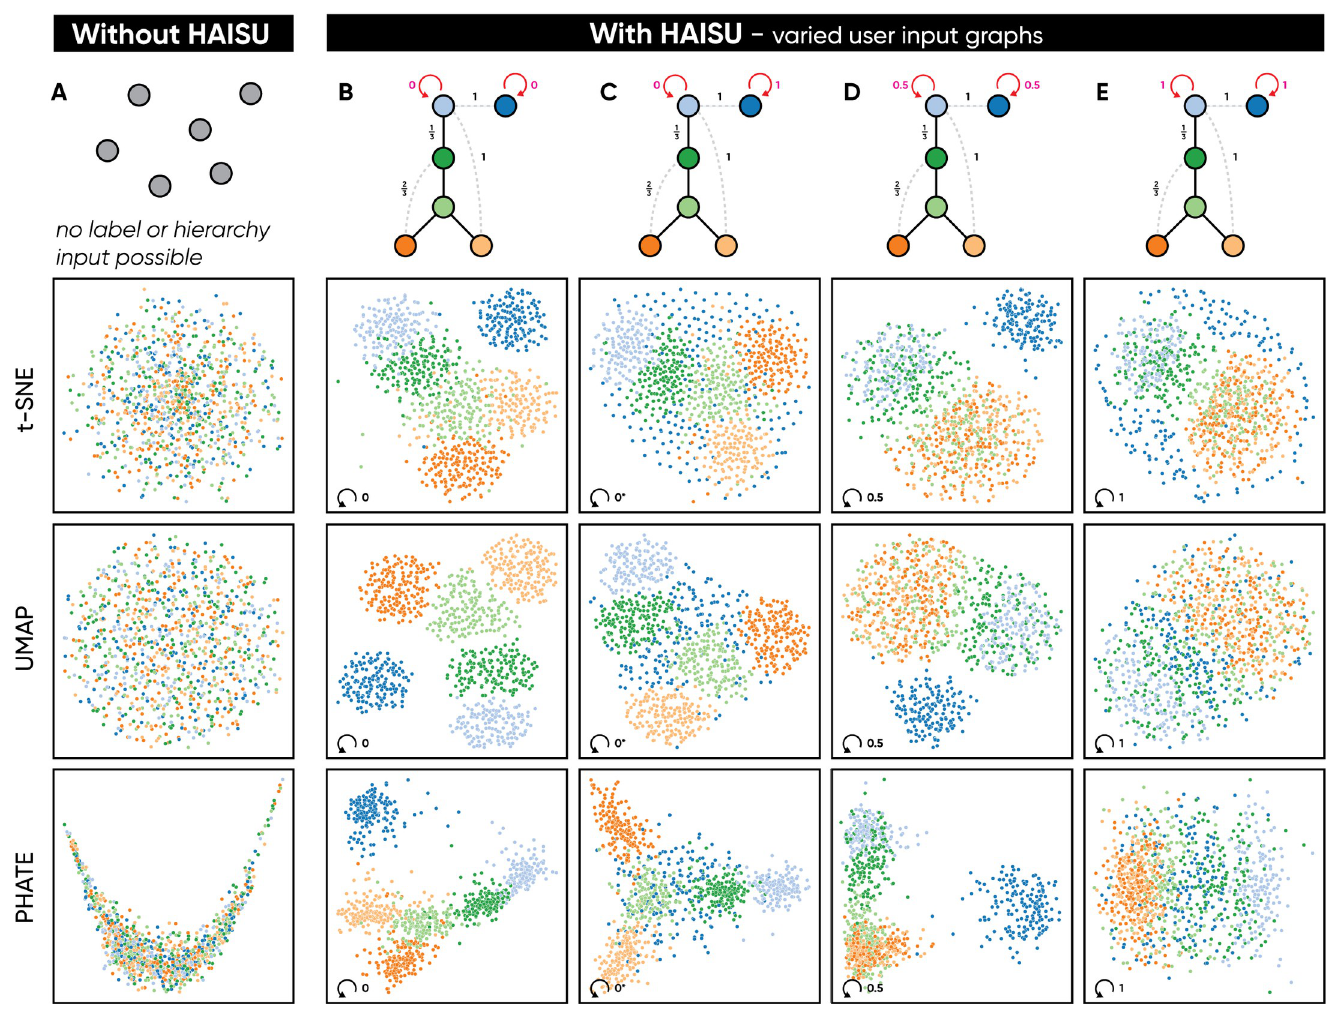
Fig 1. Users can control the effect of an input hierarchy on the resulting embedding. We demonstrate the effect of Haisu as applied to t-SNE, UMAP, and PHATE with an input graph on a set of random points. In (A) we display the unmodified embedding of each NLDR method without HAISU or any hierarchical prior. In (B), we demonstrate the default mode of Haisu where self-distance = 0; at higher str values this results in a stronger hierarchical effect on the original embedding. In (C) self-distance = 1 for the disconnected class (blue), which is penalized for clustering near itself and spreads back toward classes each point is most similar to. In (D) self-distance = 0.5 which still applies the hierarchy but encourages more inter-class interaction than (B). Finally, in (E) self-distance = 1 for all classes, which penalizes intra-class clustering, resulting in a much looser representation of the hierarchy compared with